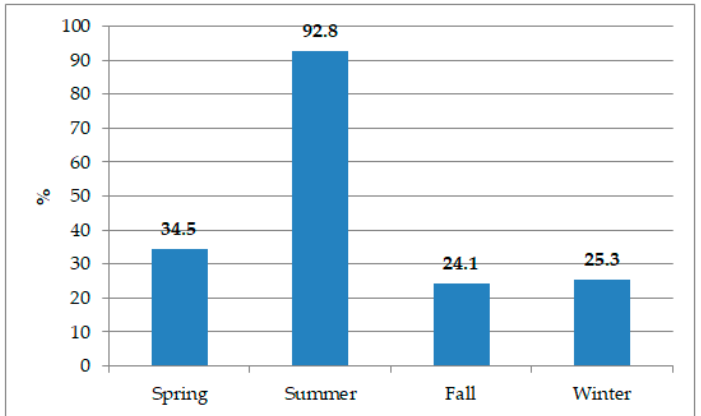
Figure 2. Distribution by visiting season.